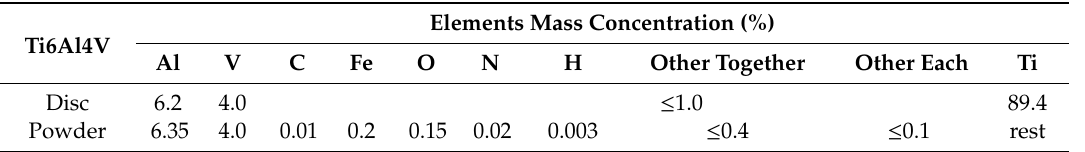
Table 1. Chemical composition of tested materials produced by computer-aided design / manufacturing (CAD / CAM) method by milling solid discs and by selective laser sintering from powders.